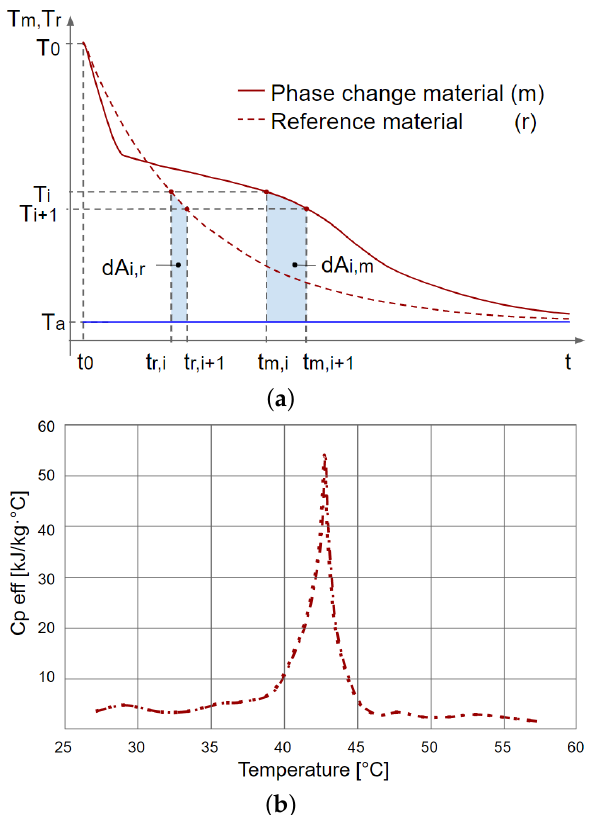
Figure 4. ( a ) Schematic representation of the effective thermal capacity calculation method; ( b ) Effective thermal capacity vs. temperature. Adapted from